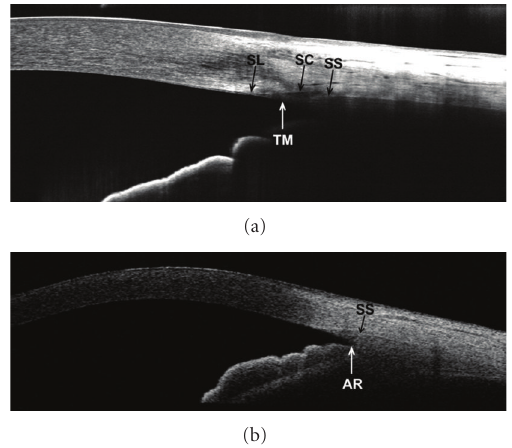
Figure 1: Two scans of the same nasal angle in a normal subject. (a) Fourier-domain RTVue OCT image using a 6mm CL-Angle scan pattern. Schwalbe’s line (SL), trabecular meshwork (TM), Schlemm’s canal (SC), and scleral spur (SS) are visible. However, the iris root (IR) and angle recess (AR) are not visible in this image. (b) Time-domain Visante OCT image using a 10 mm high-resolution corneal scan pattern. In this image, both the scleral spur and angle recess are visible, but the trabecular meshwork, Schlemm’s canal, and Schwalbe’s line are not resolvable.